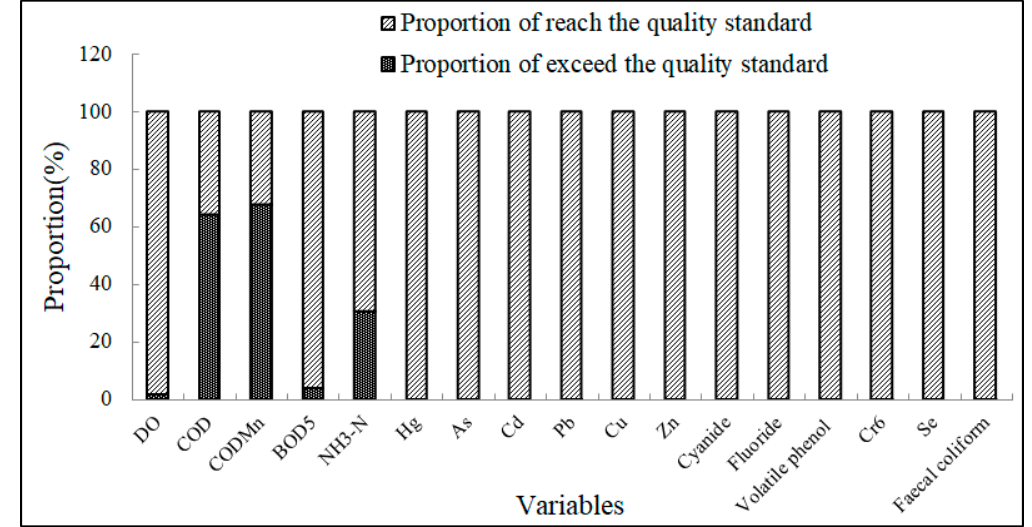
Figure 3. Proportion of monitoring values that reached and exceeded the quality standard for different variables (2011–2016). DO: dissolved oxygen; COD Mn : permanganate index; BOD: five days biochemical oxygen demand; NH 3 -N: ammonia nitrogen. Table 2. Specifications of each variable measured during the study period that exceeded the environmental quality standards for surface water.